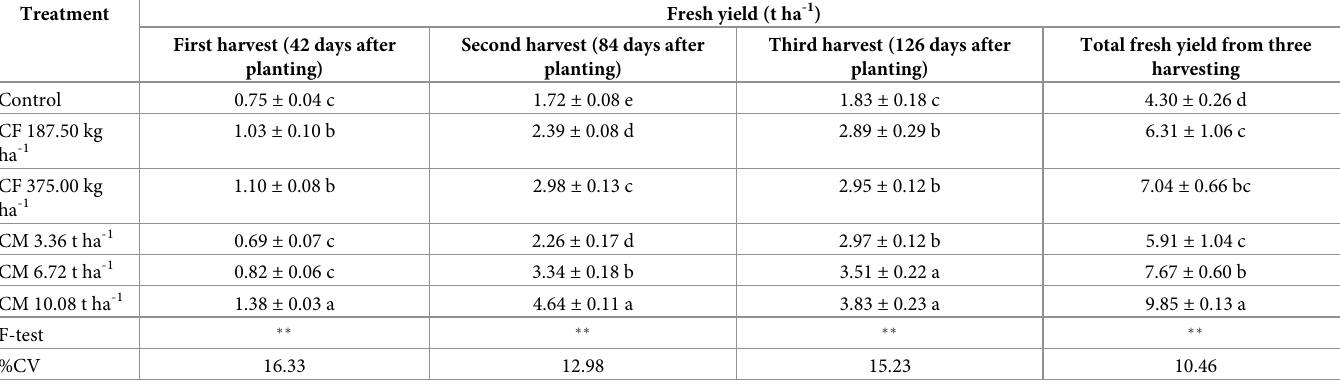
Data represent mean values ± standard deviation (SD). Mean with different letters in the same column indicate a significant difference according to Duncan’s multiple range test at p < 0.05.